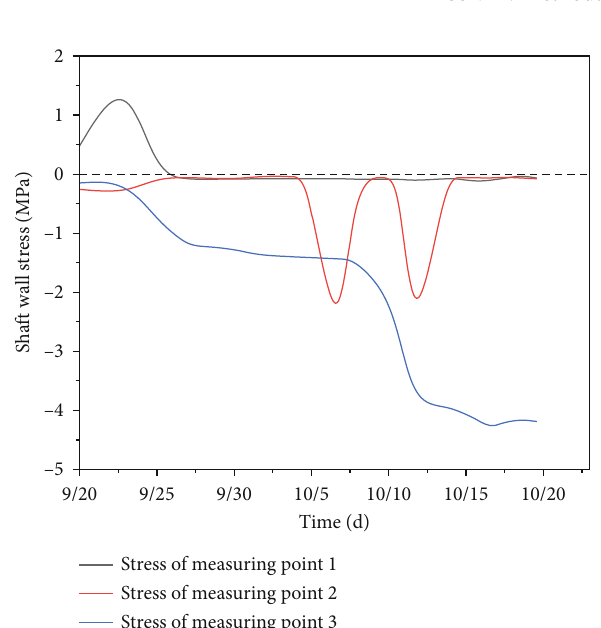
Figure 2: The law of the development of shaft wall stress with